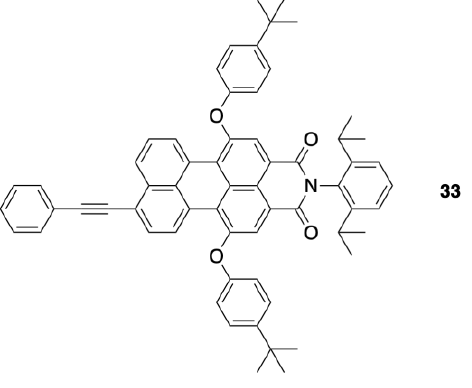
Figure 5. Absorption spectra (solid lines) and emission spectra (dashed lines) in toluene at room temperature (normalized displays). ( a ): free base porphyrin carboxy-triad 13 shows λ abs 537 nm, ε 537 nm = 67,800 M − 1 cm − 1 ; fluorescence em 743 nm upon ex = 521 nm). ( b ): zinc porphyrin isophthalate-triad 27 shows λ abs 548 nm, ε 548 nm = 99,800 M − 1 cm − 1 ; fluorescence λ em 733 nm upon λ ex = 549 nm). ( c ): perylene 33 (fluorescence λ em 566 nm upon λ ex ~500 nm). ( d ): trans -AB zinc porphyrin 31 (fluorescence λ em 633 nm upon λ ex = 415 nm).